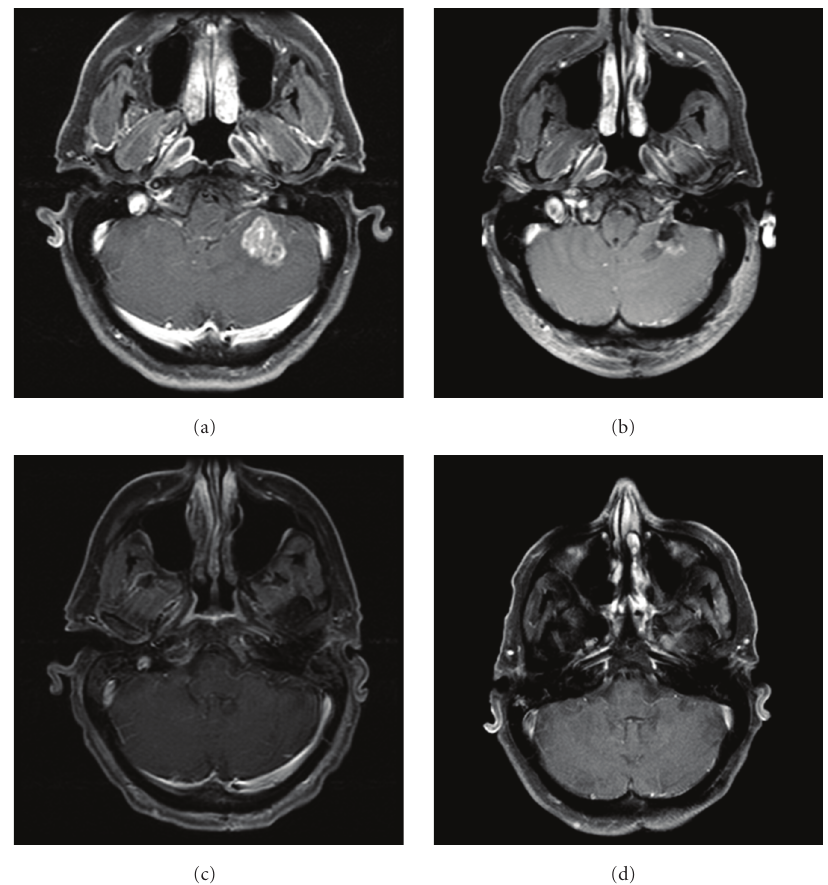
Figure 1: Axial, T1-weighted, postcontrast MR images of the brain. (a) A 2.3 × 2.3 × 2.5cm left cerebellar lesion occurred synchronous with the diagnosis of a primary NSCLC. (b) The left cerebellar lesion was completely removed through a left suboccipital craniectomy. (c) No residual enhancement is noted after WBRT. (d) There is no evidence of recurrent brain metastasis on MRI obtained 2 years after